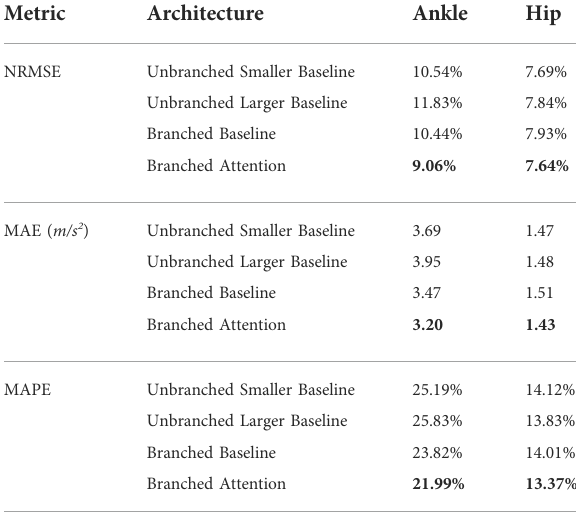
TABLE 2 Model evaluation on the testing dataset (error in resultant acceleration predictions).